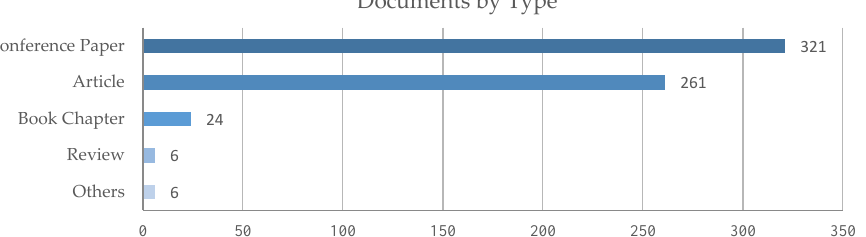
Figure 3. The distribution of the identified set of documents by document type. About 52% are conference papers and 42% are articles, and each of the other categories is below 4%.